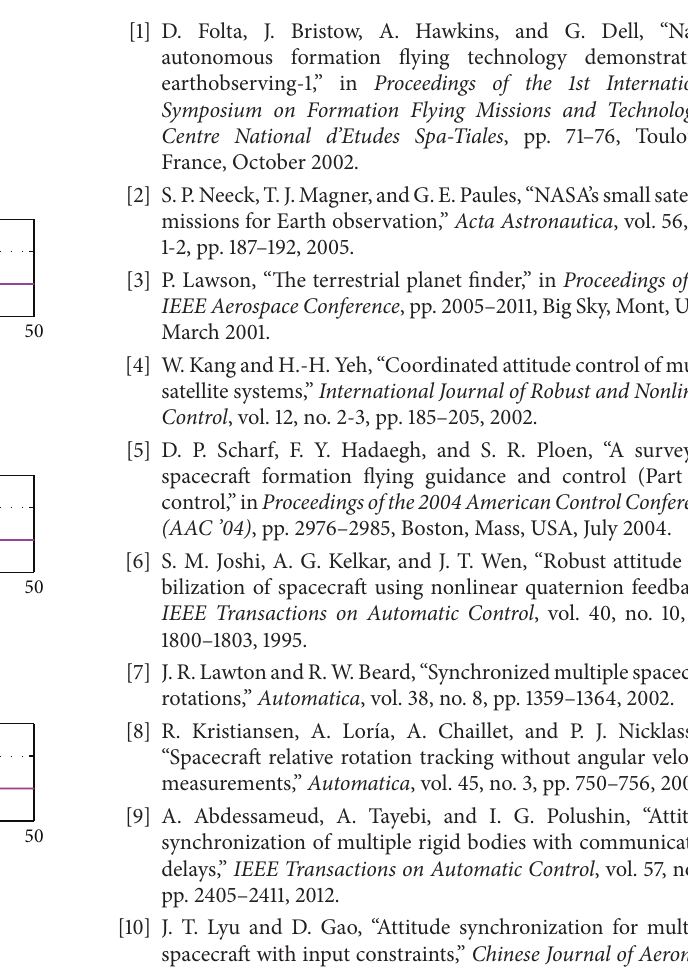
Figure 7: The auxiliary vectors 𝜉 𝑖